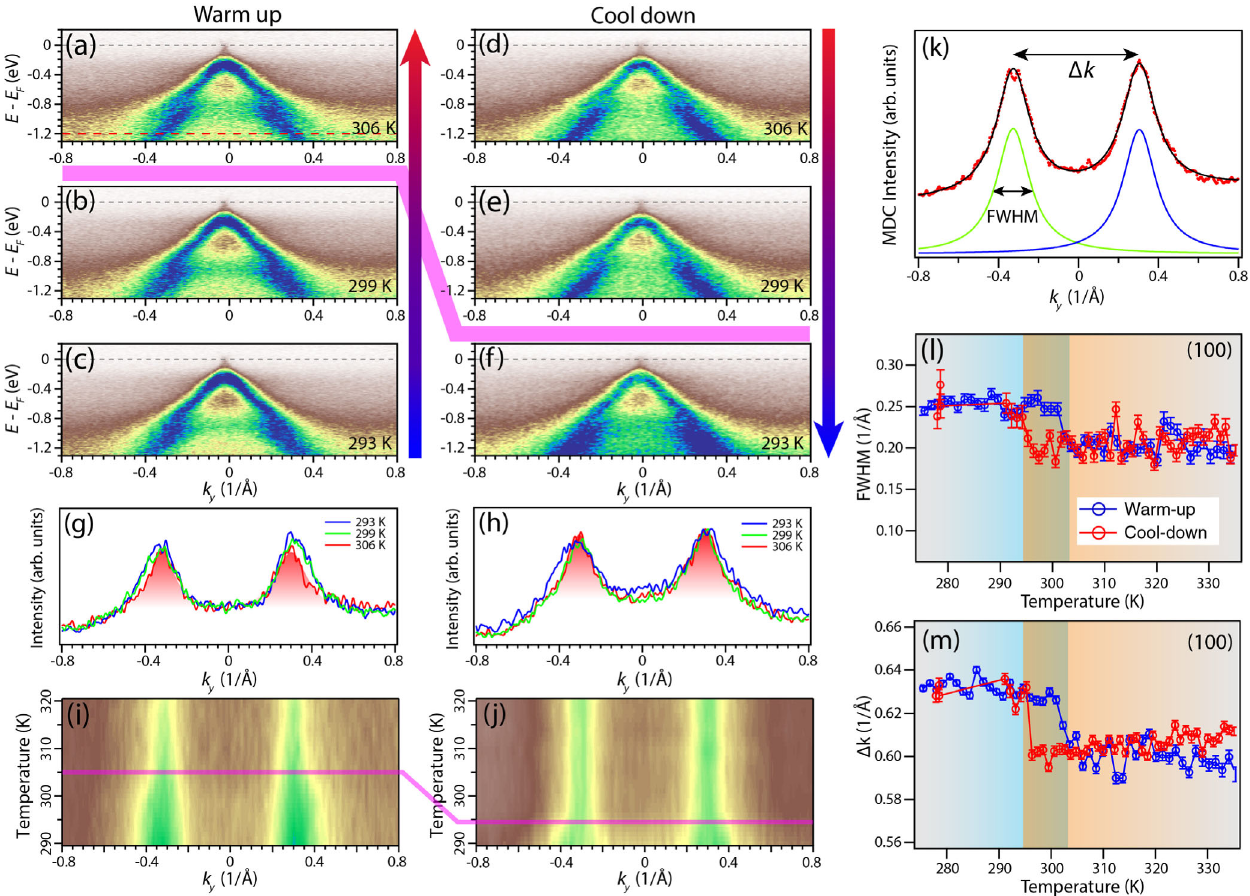
FIG. 3. Bulk band doubling across the phase transition. (a) – (c) Warm-up and (d) – (f) cool-down band images measured along cut 1 indicated in Fig. 2(a) at selected temperatures. (g), (h) Corresponding MDCs at − 1 . 2 eV during warm-up and cool-down, respectively. (i) Warm-up and (j) cool-down false-color images showing a more detailed temperature evolution of the MDCs indicated in (a). (k) Example of a MDC fitted by two Lorentzian peaks. (l) Full width at half maximum of the MDC fittings indicated in (k) as a function of temperature. The warm-up results are shifted 0.04 Å − 1 upward. (m) The separation of the peak positions of the MDC fittings indicated in (k) as a function of